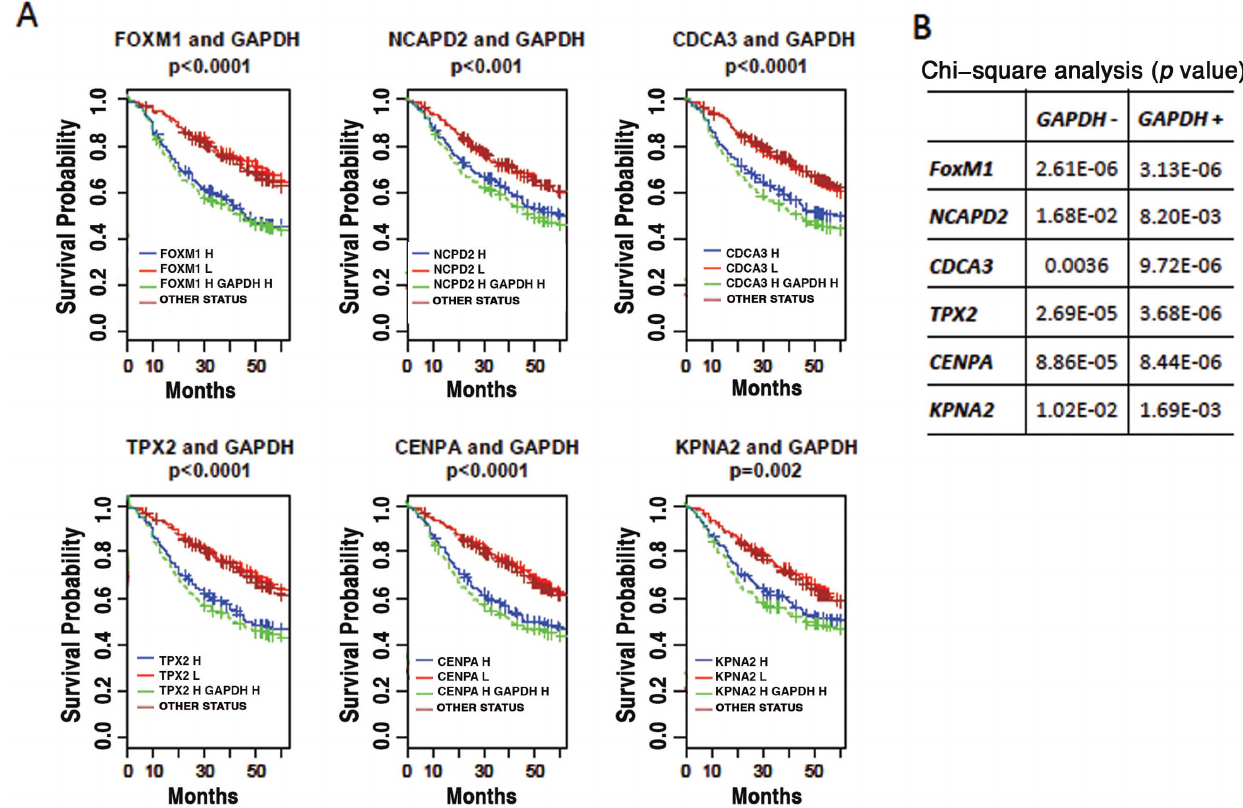
Figure 6. Prognostic significance of up-regulation of top ranked GACC genes and GAPDH in lung adenocarcinomas. (A) Director’s Challenge cohort with 442 lung adenocarcinomas from caArray for Kaplan-Meier survival analysis. The up-regulation of all selected top ranked GACC gene is associated with poor prognosis. Combination of up-regulation of GAPDH with individual GACC gene improves the prediction power (high GACC gene expression and high GAPDH expression (green line) vs high GACC gene expression alone (blue line)). H=high. L=low. (B) Statistical significance of Kaplan-Meier survival analysis using individual GACC gene as marker ( GAPDH 2 ) or combination of GACC gene and GAPDH ( GAPDH + ) as markers. The table lists p values of chi-square